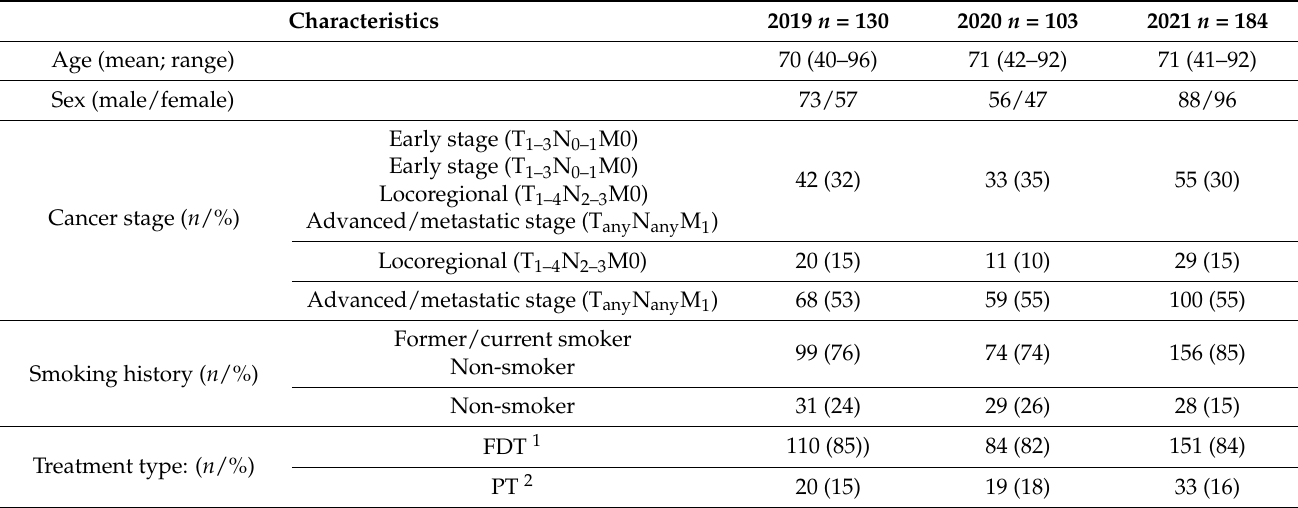
Table 2. Patients’ characteristics.